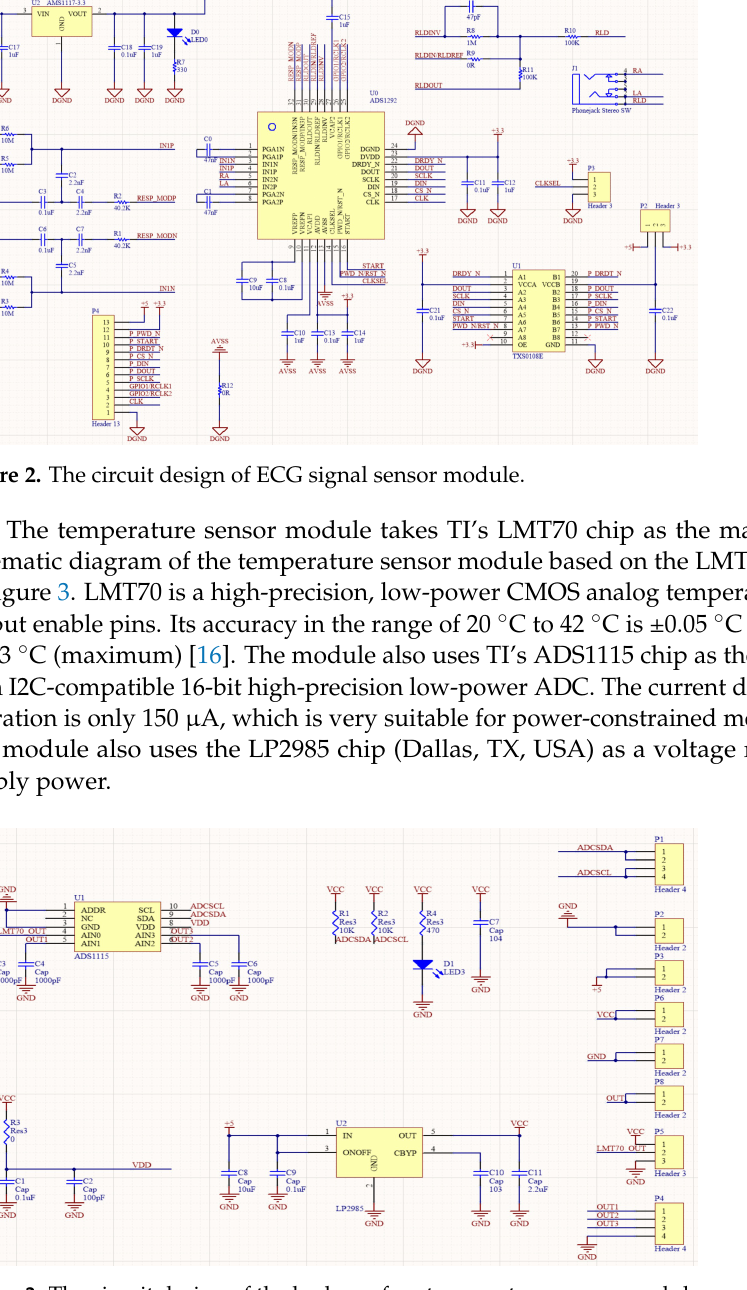
Figure 3. The circuit design of the body surface temperature sensor